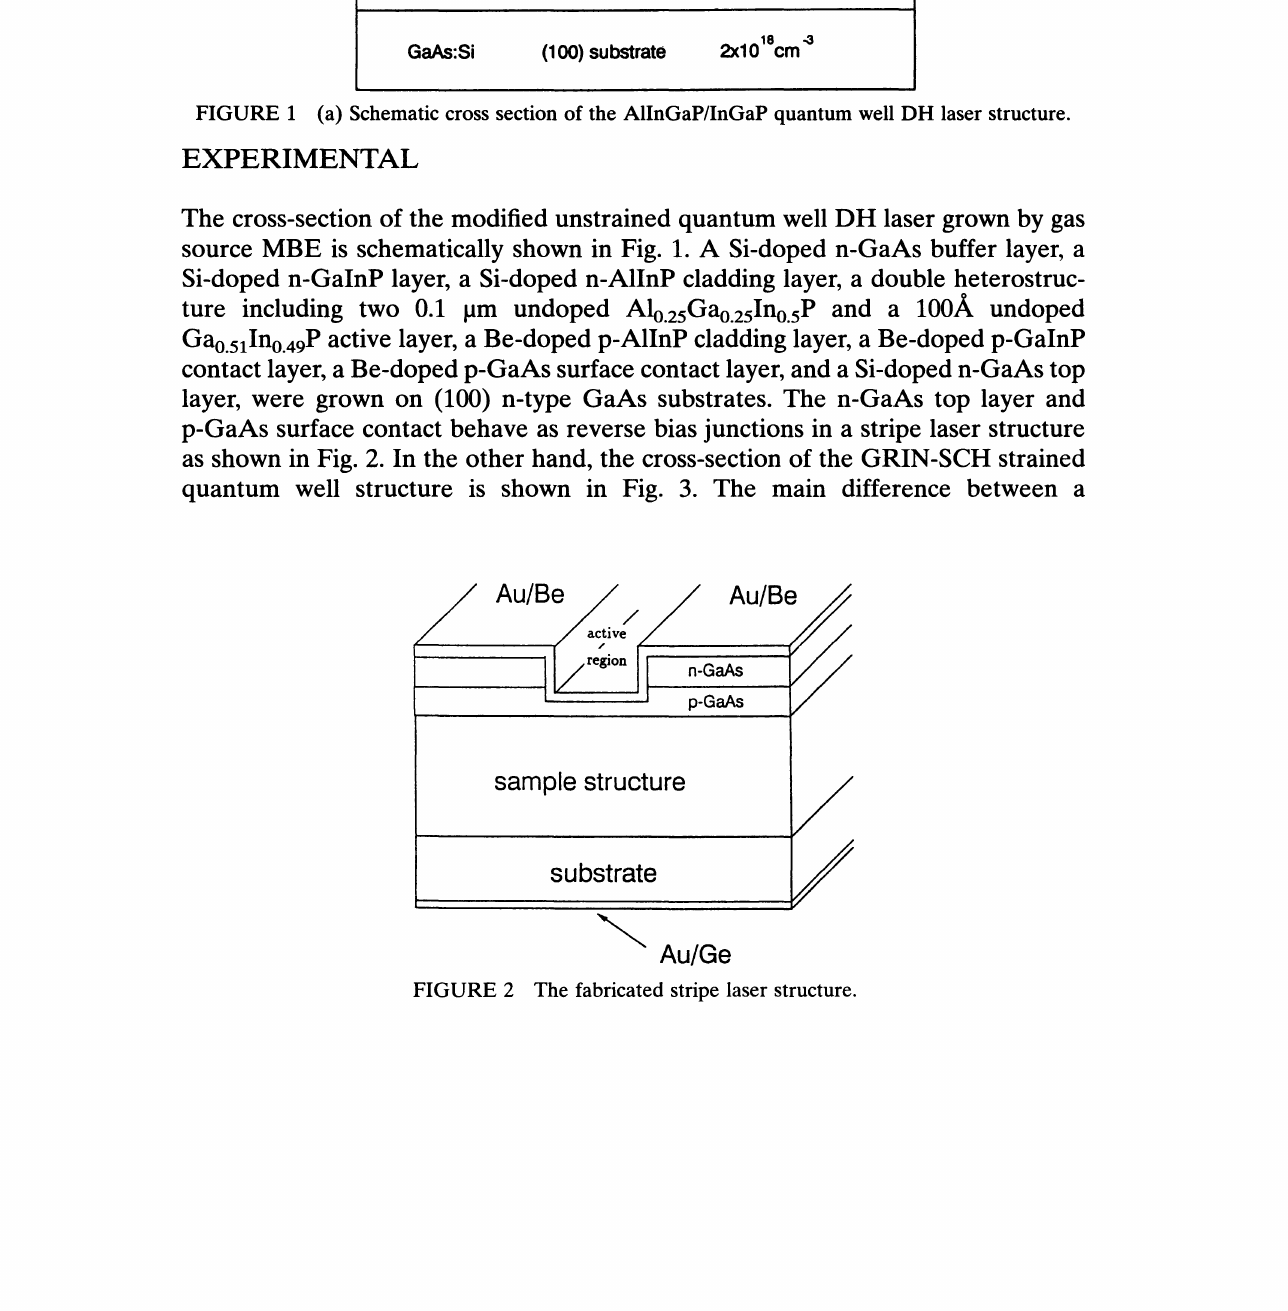
FIGURE 2 The fabricated stripe laser